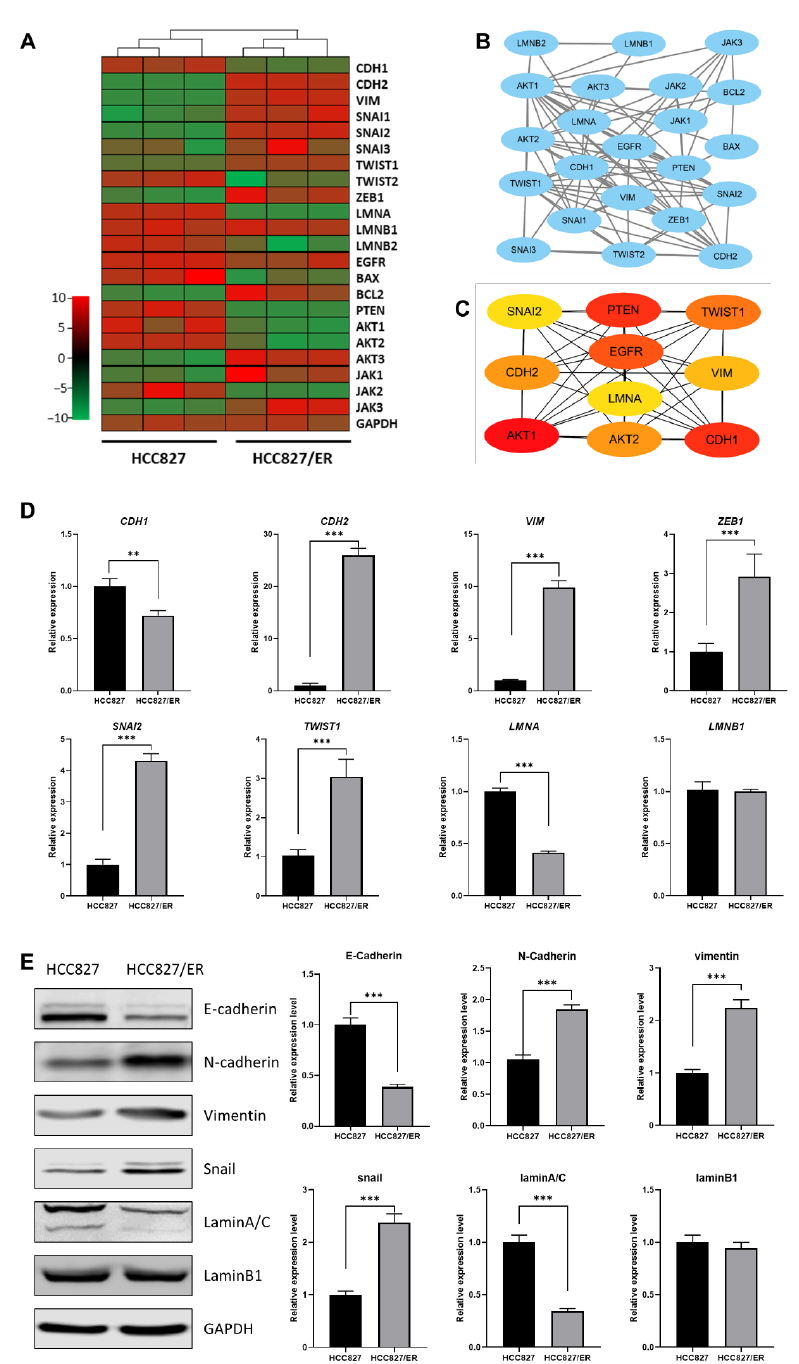
Figure 2. Relationship between LMNA and the EMT-related gene between HCC827 and